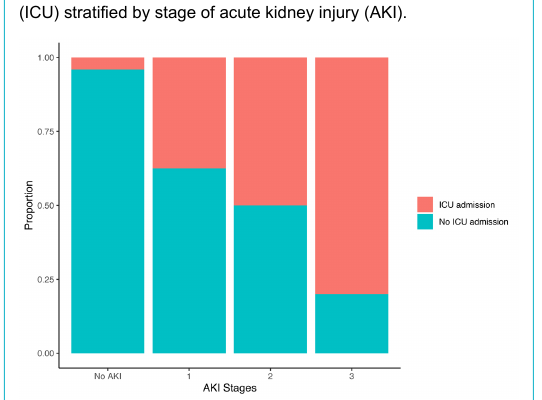
Figure 1: Proportion of patients admitted to the intensive care unit (ICU) stratified by stage of acute kidney injury (AKI).